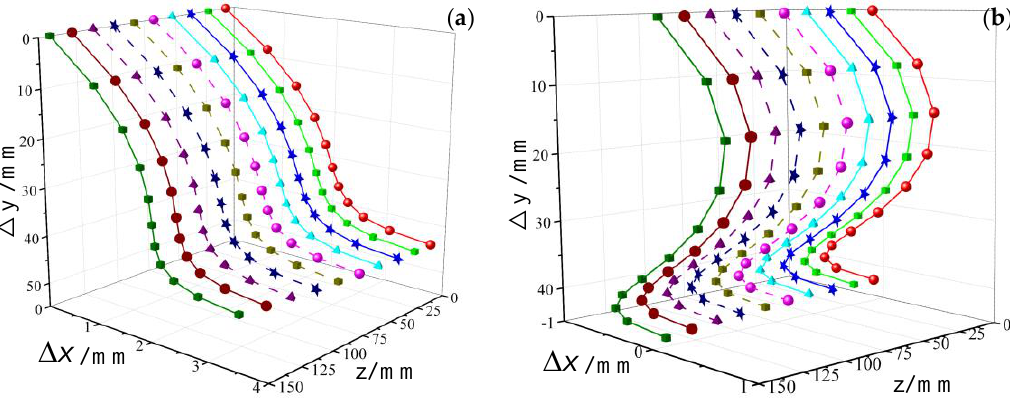
Figure 17. Loading trajectories for discrete clamps. ( a ) Stretch-forming process based on equal elongation (SF-e). ( b ) Stretch-forming process based on variable elongation (SF-v).